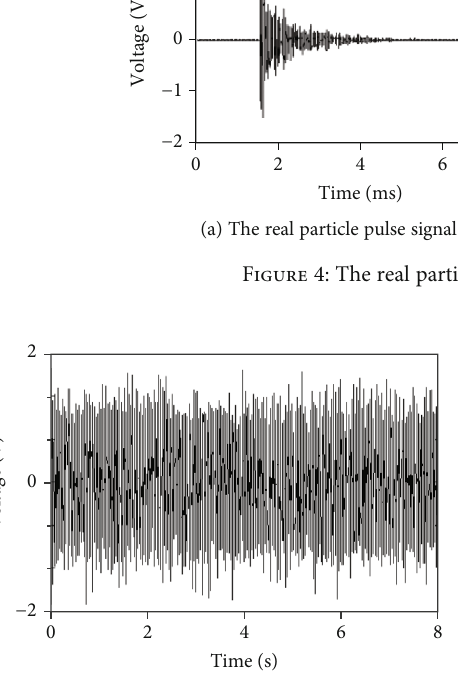
Figure 5: The simulated particle pulse signal with noise. numerical iteration algorithm for solving nonlinear sto- chastic di ff erential equations [28, 29].